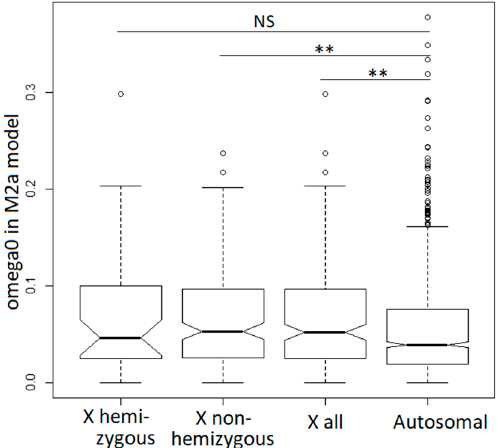
Figure 4. Relaxed purifying selection in X-linked compared to autosomal genes. The significance was tested with the Wilcoxon rank sum test (** p < 0.01).